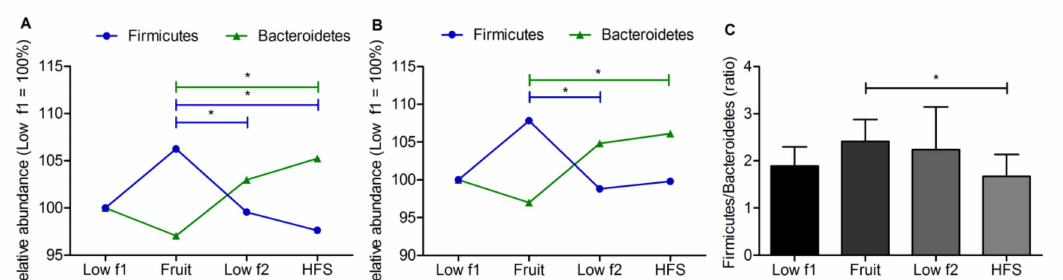
Figure 3. Significant changes between fructose diet phases on phylum level. Relative abundance of Bacteroidetes and Firmicutes in all ( n = 12) ( A ) and obese ( n = 6) subjects ( B ). ( C ) Firmicutes / Bacteroidetes ratio of all subjects. Data are shown as mean ± standard error of the mean (SEM). ( A , C ) Significant di ff erences are indicated as * adj. p -value < 0.05. ( B ) Significant di ff erences are indicated as * p -value <